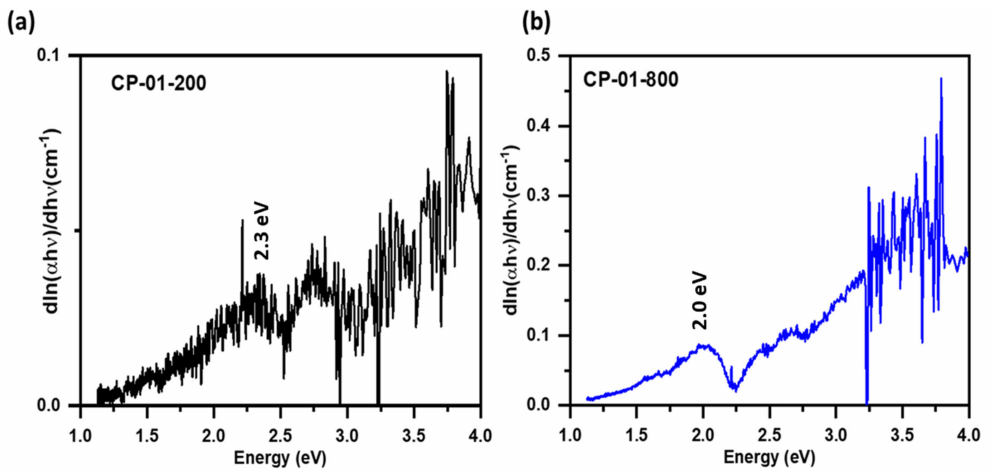
Figure 3. Determination of bandgap energy using of titanium ferrite nanopowder calcined at ( a ) 200 and ( b ) 800 ◦ C temperatures using dln( α h ν )/dh ν plot of corresponding UV–visible absorption